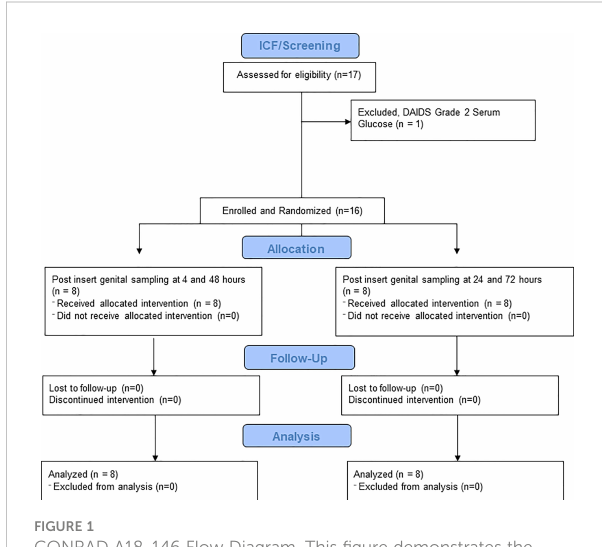
FIGURE 1 CONRAD A18-146 Flow Diagram. This fi gure demonstrates the number of volunteers screened, enrolled, randomized and